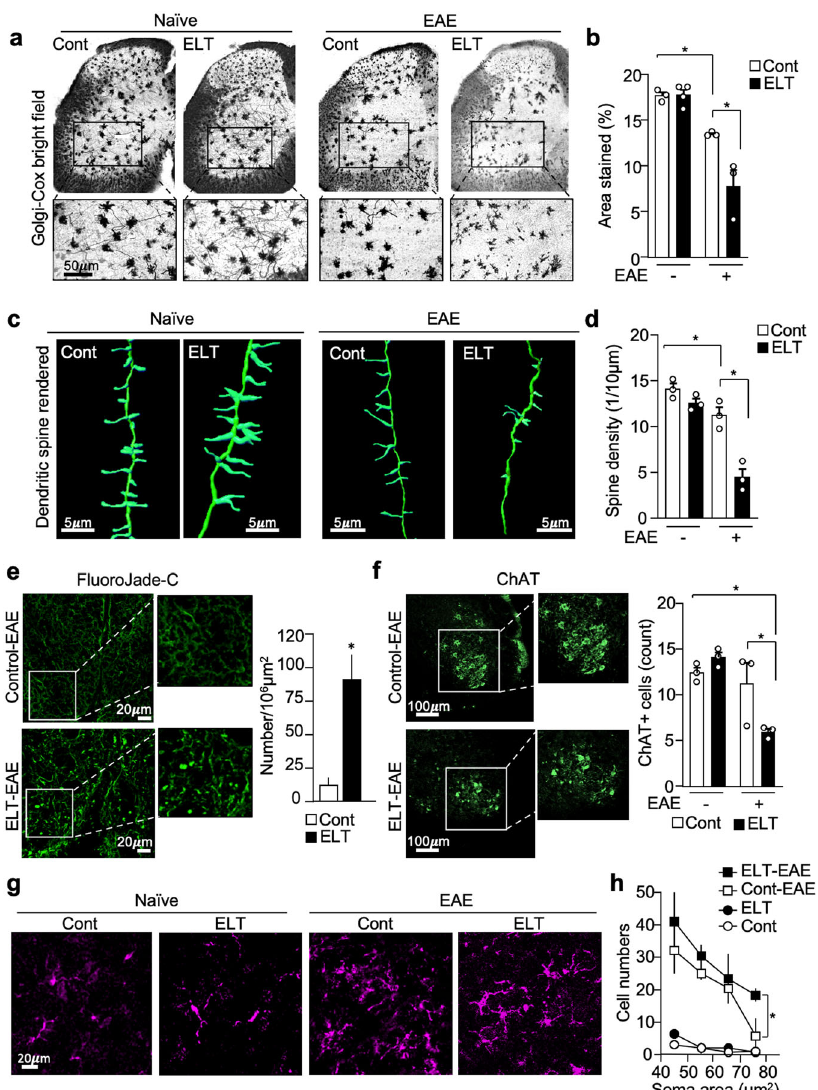
area stained/per fi eld ( b ) (Cont naïve: n = 3, ELT naïve: n = 4, Cont EAE: n = 3, ELT-EAE: n = 3). c , d CRSR imaging of Golgi – Cox-stained dendrites in lumbar spinal cord ventral horn region ( c ) with quanti fi cation of dendritic spine density at 30 dpi ( d ) ( n = 3 animals/group, 60 dendrites/group). e FluoroJade-C-stained lumbar spinal cord sections of EAE mice isolated at 20 dpi with quanti fi cation of area stained/per fi eld (Cont EAE: n = 7, ELT-EAE: n = 4). f ChAT + neuron-stained lumbar spinal cord sections of EAE mice isolated at 30 dpi ( n = 3 per group). g Representative image of Iba1 + cells in spinal cord ventral horn at 30 dpi. Representative image was randomly selected from pooled images from two independent staining experiments. h Iba1 + cell count categorized by soma size in the lumbar spinal cord ventral horn (L5 – 6) at 30 dpi ( n = 3 per group). Each dot represents averaged data per animal. Data are represented as mean ± SEM. Two-tailed Student ’ s t -test, * P < 0.05. Exact P values for asterisks (from left to right): b 0.0005,